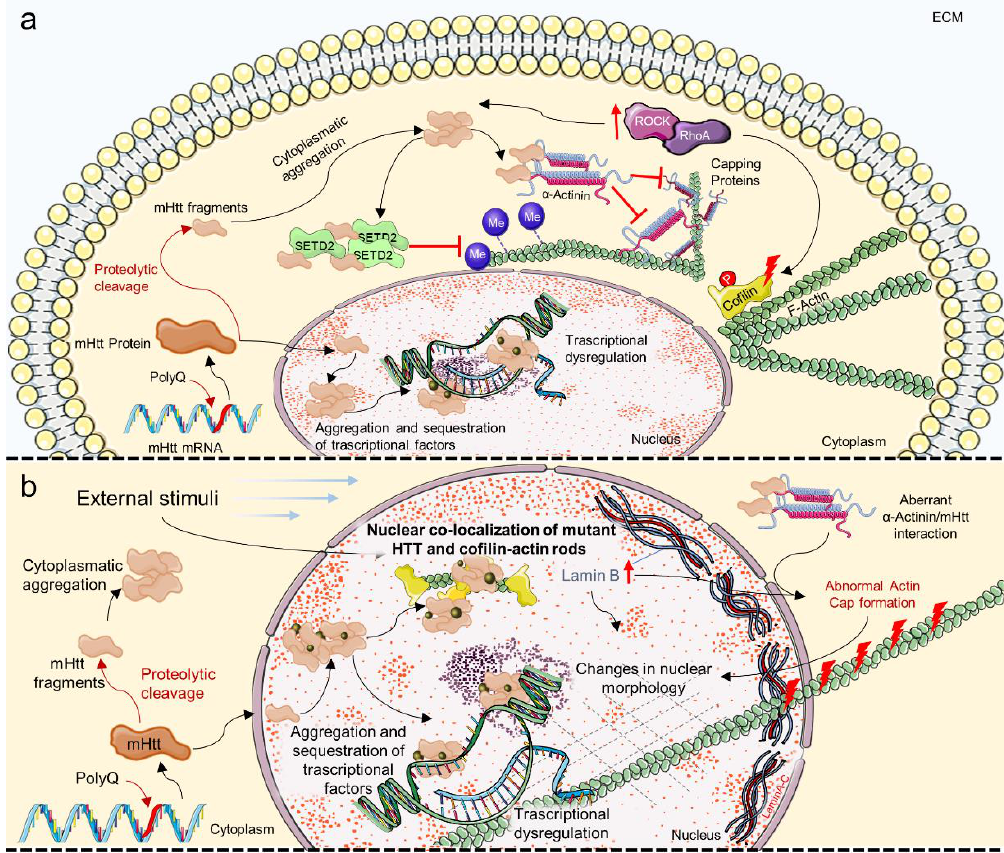
Figure 4. Biochemical pathways of cellular mechanosensing and mechanotransduction involved in Huntington’s Disease pathological mechanisms: ( a ) Molecular mechanism of mutant Huntingtin (mHTT) aggregates formation and their effect on cytoskeletal homeostasis and Actin dynamic, and on ( b ) nuclear architecture and functioning (see main text for details). Red arrows up ↑ indicate upregulation. Me, Methyl; mHTT, mutant Huntingtin; PolyQ, Polyglutamine; RHOA, Ras homolog family member A; ROCK, Rho-associated protein kinase; SETD2, Histone-lysine N-methyltransferase SETD2.